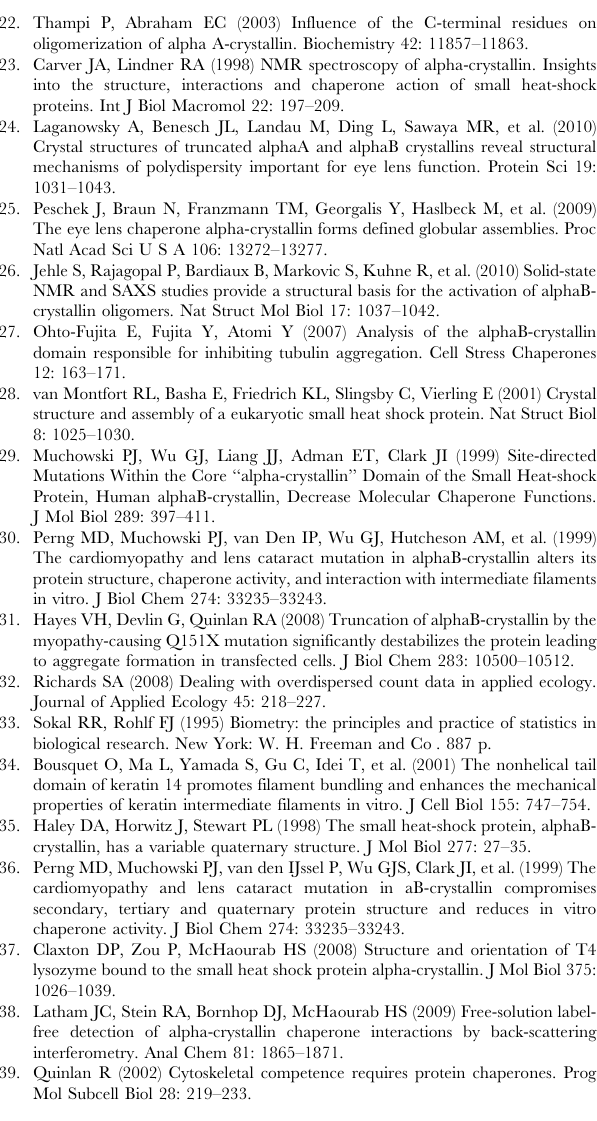
Figure S1 Electron microscopy characterisation of the a B- crystallin proteins used in this study. The a B-crystallin samples were stained with 1% (w/v) uranyl acetate and then processed for electron microscopy. All proteins appeared as monodisperse particles. Scale bar represents 100